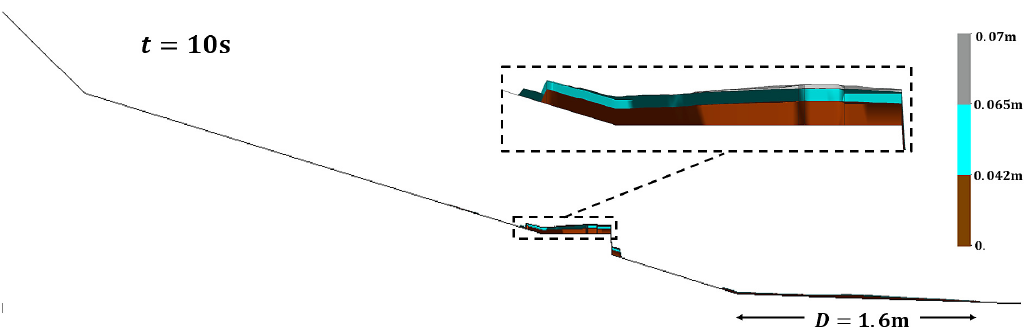
Figure 7. The numerical results of final deposit thickness consisting of solid, fluid, and air phases. The flow heights recorded by sensors (fh-1, fh-2, and fh-4) and the computed flow heights (SPH-1, SPH-2, and SPH-4) at distances of 2.6 m, 5 m, and 5.6 m are plotted in Figure 8. The arrival time of the flow front obtained from the presented numerical